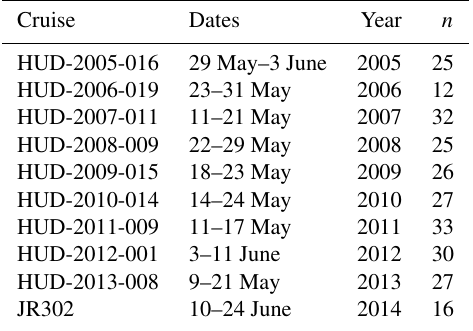
Table 1. Research cruises, sampling dates, and number of samples per cruise ( n ) where pigment data were collected in the Labrador Sea during early spring and late summer (2005–2014). HUD-Year- ID and JR302 refer to expeditions carried out on board the CCGS Hudson (Canada) and RRS James Clark Ross (UK),